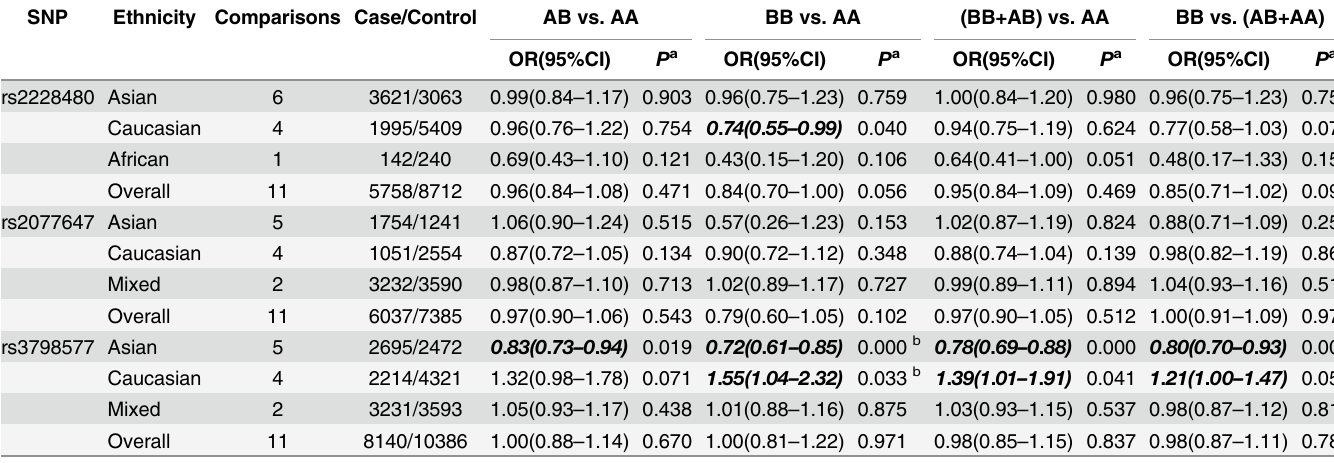
Table 2. Pooled ORs of the three SNPS in the different genetic models and in different ethnic